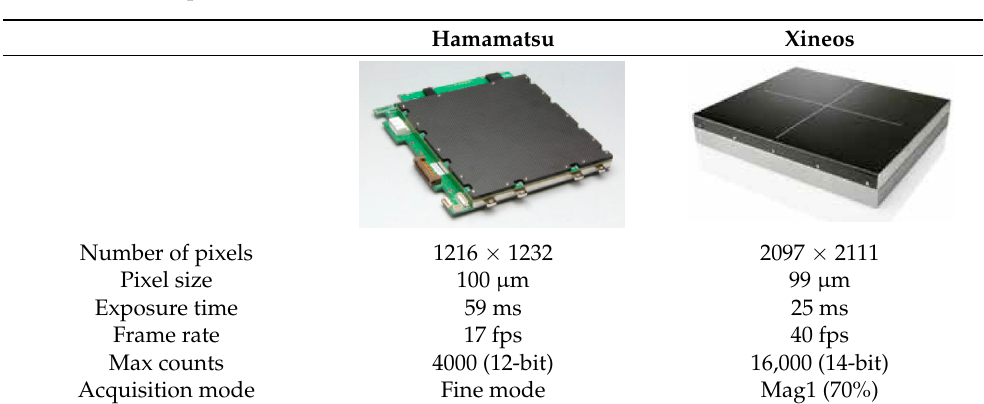
Table 1. Detector specifications for the Hamamatsu C10900D [42] and the Xineos 3030HR [43].